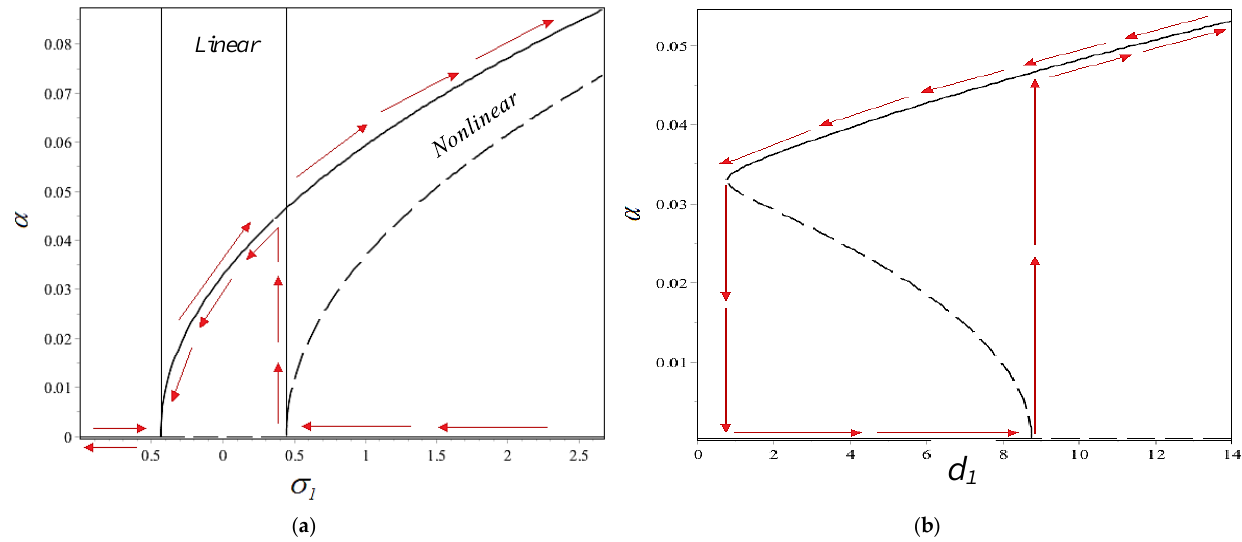
Figure 4. ( a ) A typical frequency–amplitude response of the system for the parametric resonance; ( b ) a typical response curve of the system for the parametric resonance. The frequency responses of the quadratic curve with different waviness are shown in Figure 5a. Accordingly, for the lower waviness, the hardening behavior is observed and by increasing this parameter, the system response moves to the left, at which the system d 1